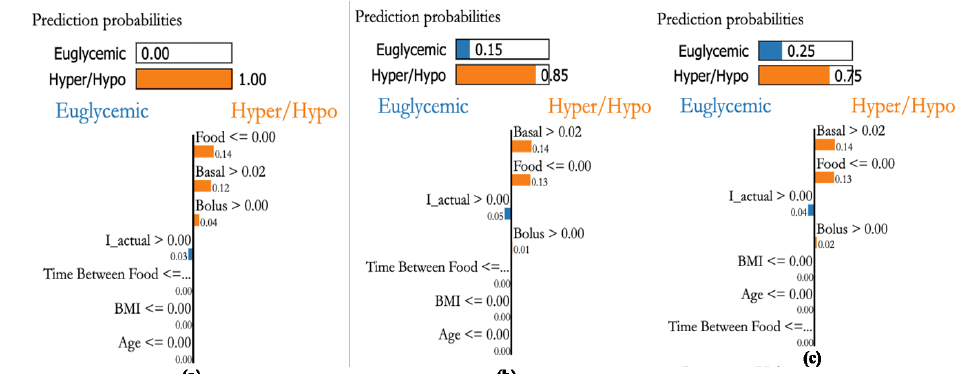
Figure 23. Explanations for three randomly selected samples of patient P1. ( a ): Sample showing hyper condition and explained through basal and bolus values even though CHO is low, ( b ): A hyper glycemic sample explained through basal values even when the food CHO is low, and ( c ): random sample detected to be hyper glycemic based on basal and bolus